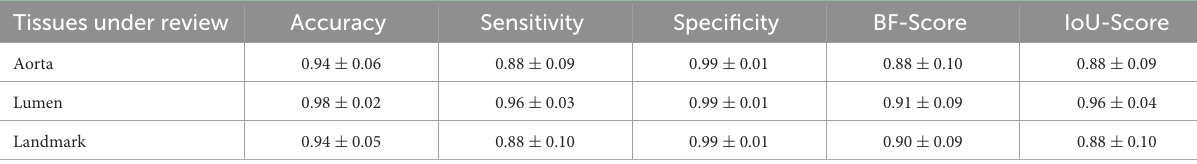
TABLE 7 Measured accuracy, sensitivity, specificity, BF-score, and IoU-score to evaluate the model performance on an external cohort of six different patients that were not included in any of the training, test, and validation sets and were only used for algorithm verification. Tissues under review